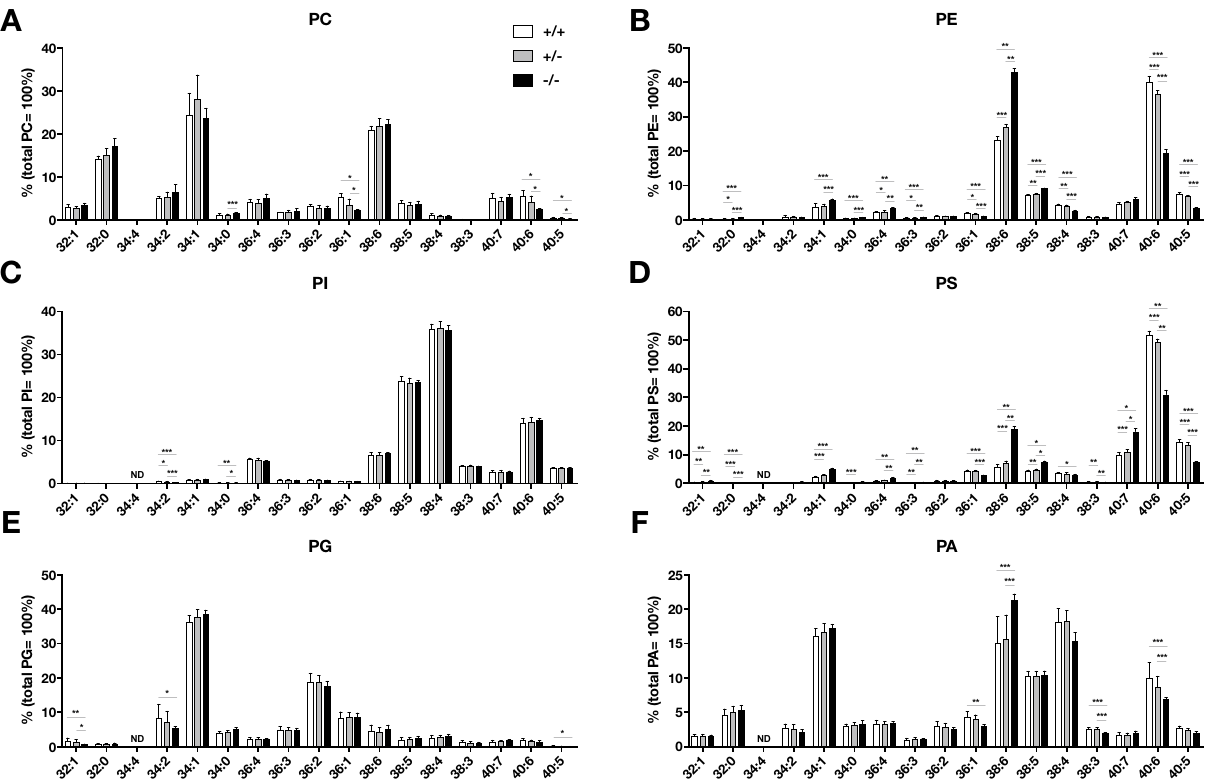
Figure 6. Lipidomic analyses of lpgat1 mutant zebrafish. Lipids were collected at 7 days post fertilization from a single zebrafish larva obtained from crossing an lpgat1 +/− male with an lpgat1 +/− female and analyzed for phosphatidylcholine (PC, A ), phosphatidylethanolamine (PE, B ), phosphatidylinositol (PI, C ), phosphatidylserine (PS, D ), phosphatidylglycerol (PG, E ), and phosphatidic acid (PA, F ) by LC–MS/MS. Genotypes of each larva were determined by PCR after a lipid sample was collected. The fish were obtained from three independent crosses. The numbers of samples were n = 18 for lpgat1 +/+ , n = 19 for lpgat1 +/− and n = 7 for lpgat1 −/− . Error bars are S.D. Statistically significant differences are marked with asterisks. * p < 0.05; ** p < 0.01; *** p < 0.001. Two-way ANOVA, Bonferroni’s multiple comparison test was used. For molecular species with low abundance, the relative abundance of each molecular species is shown in Supplementary Fig.